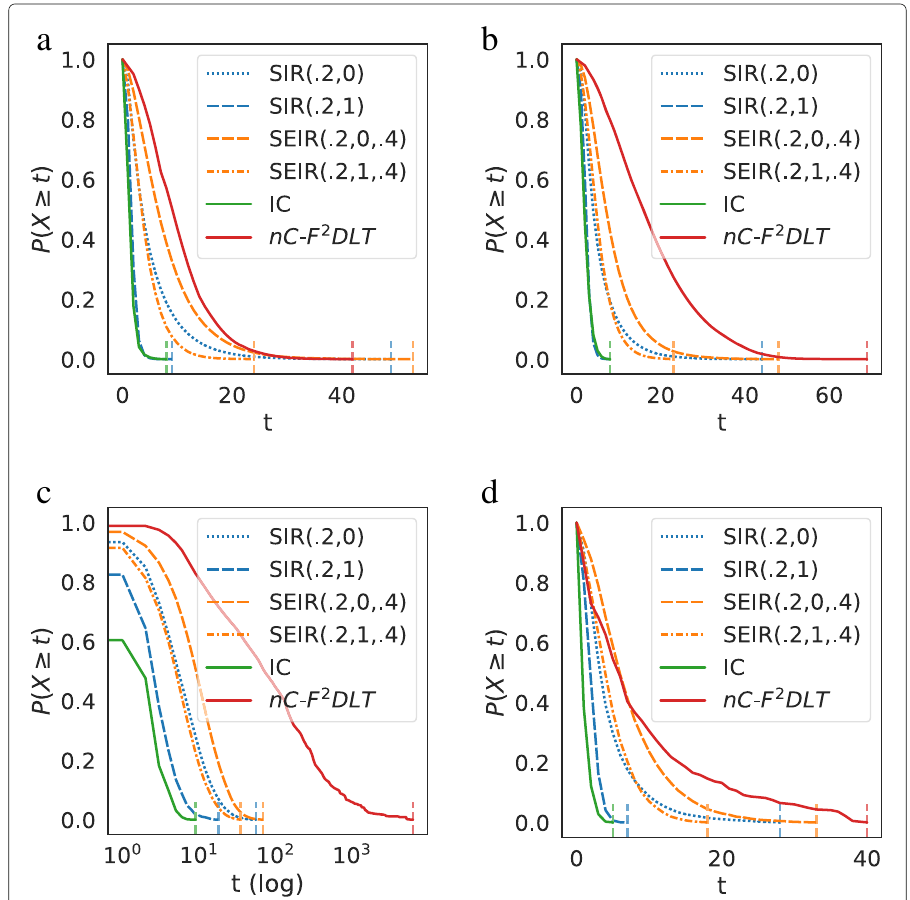
Fig. 15 Complementary cumulative distribution functions of node activations/infections for nC - F 2 DLT , IC, SIR ( β = 0.2 and γ ∈ { 0,1 } ), and SEIR ( β = 0.2, γ ∈ { 0,1 } , σ = 0.4), using k = 50 and strategy I-Sources. a Epinions. b Slashdot. c Wiki-Conflict. d Wiki-Vote